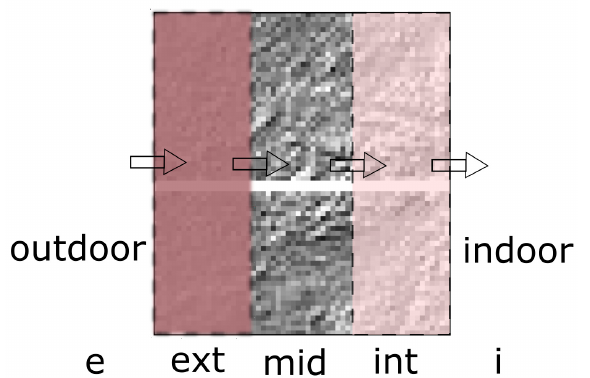
Figure 13. Fluxes of heat between the layers, the direction of the arrows indicates a positive value.